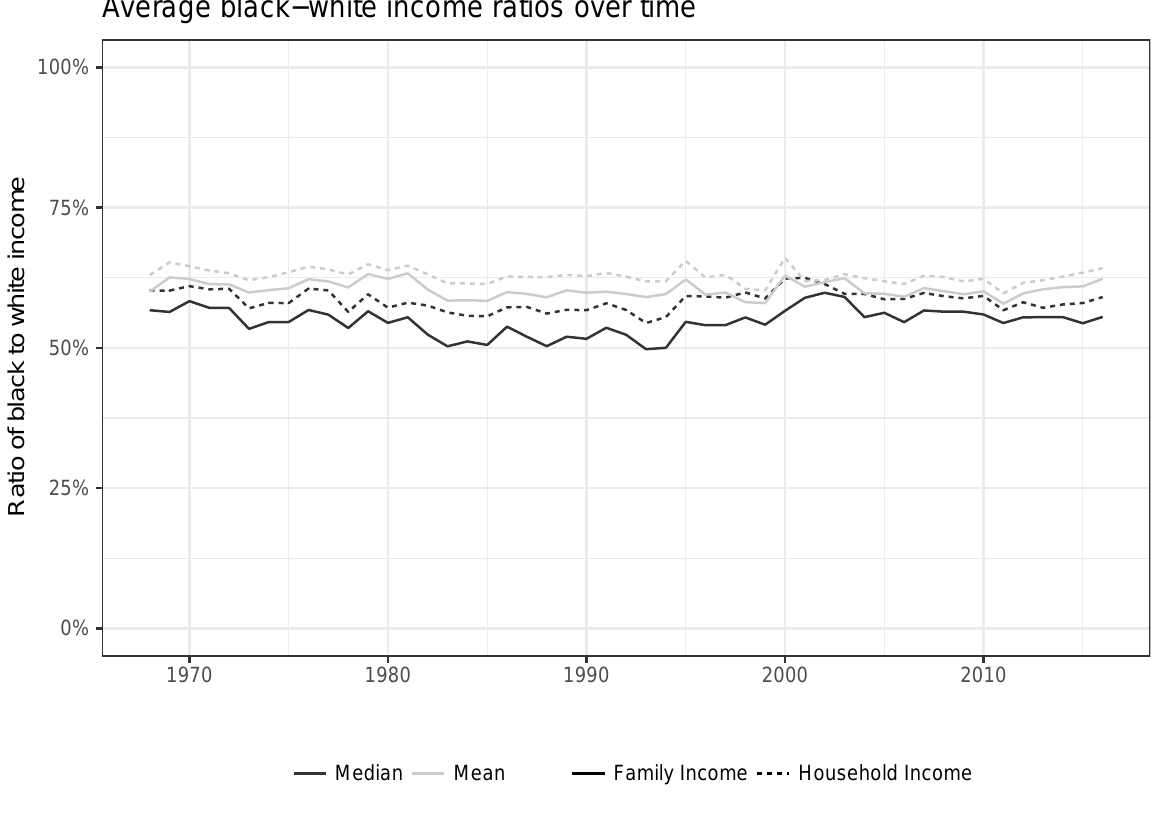
Figure 2: Median and mean black-white income ratios over